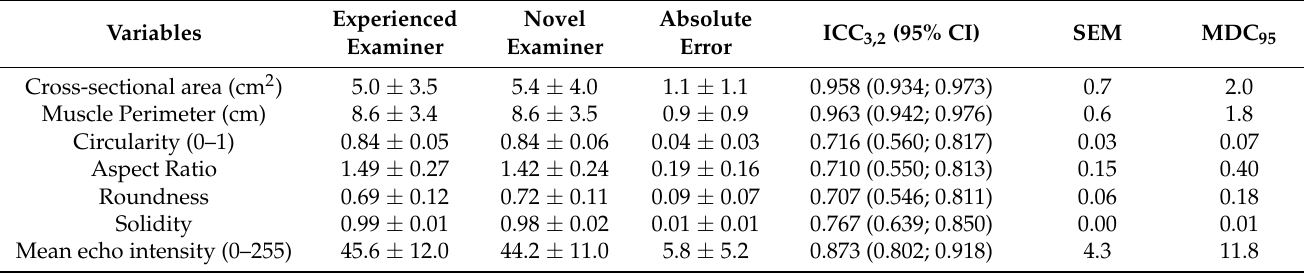
Table 2. Inter-examiner reliability for the anterior scalene US metrics.